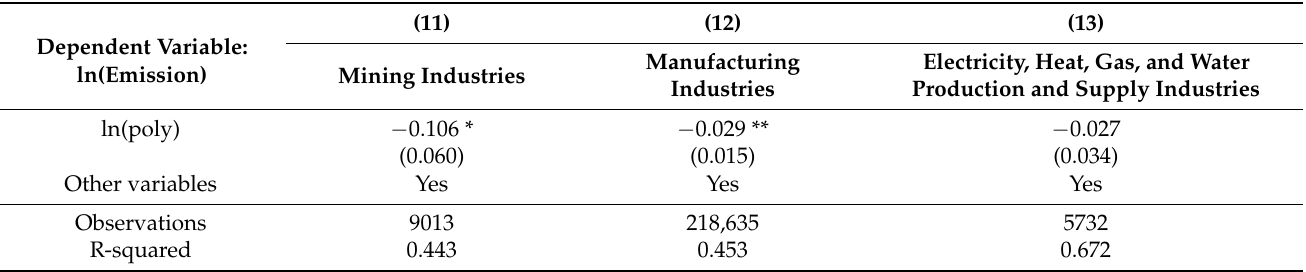
Table 5. Tests for different